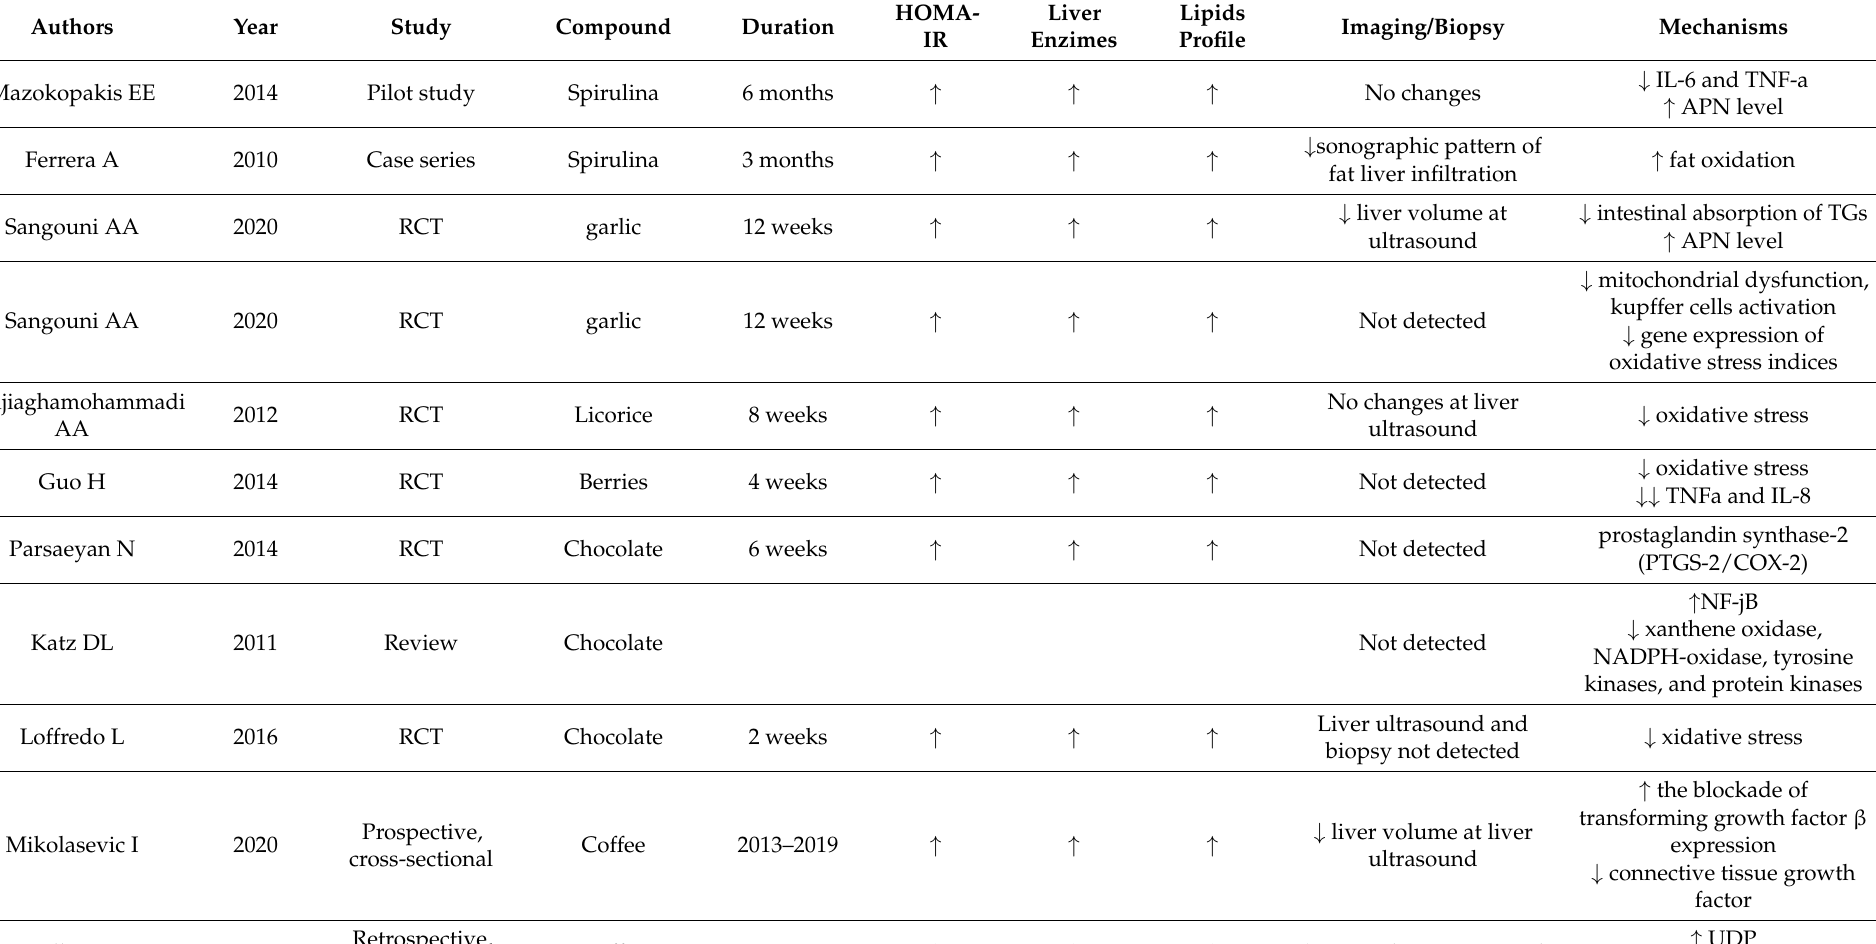
Table 1. Characteristics of clinical studies taken into account to prove the efficacy of natural products on